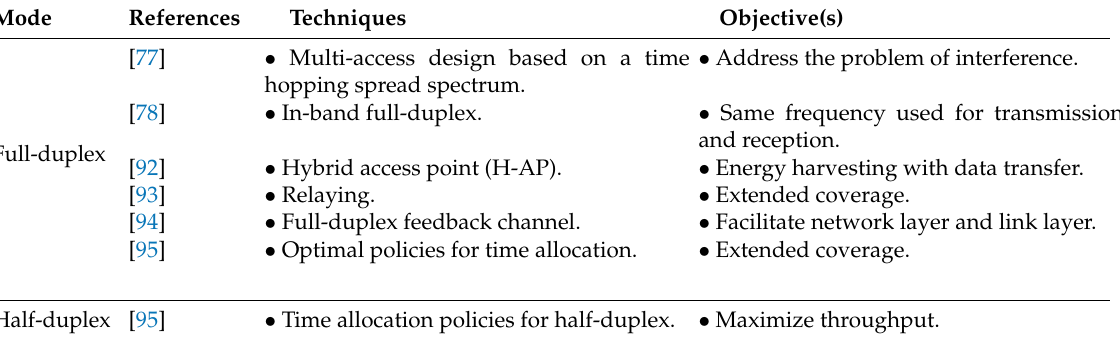
Table 6. Summary of communication modes in